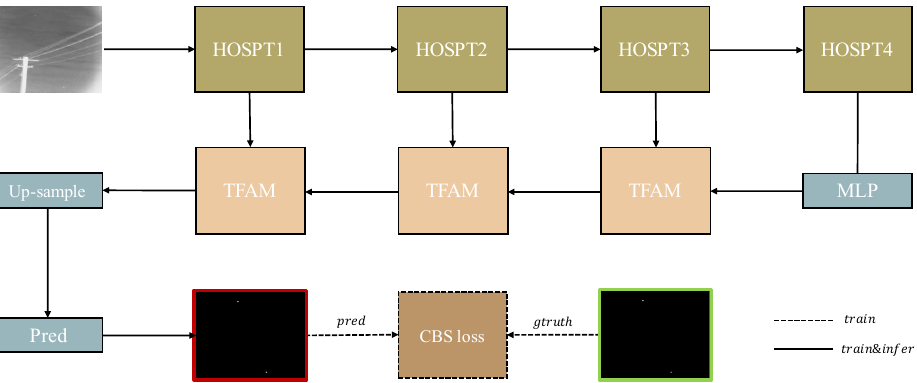
Figure 2. The architecture of the proposed IRSTFormer, which consists of a four-stage encoder hierarchical overlapped small patch transformer (HOSPT), a progressive decoder with top-down feature aggregation modules (TFAM), and the combined BCE and softIoU (CBS)